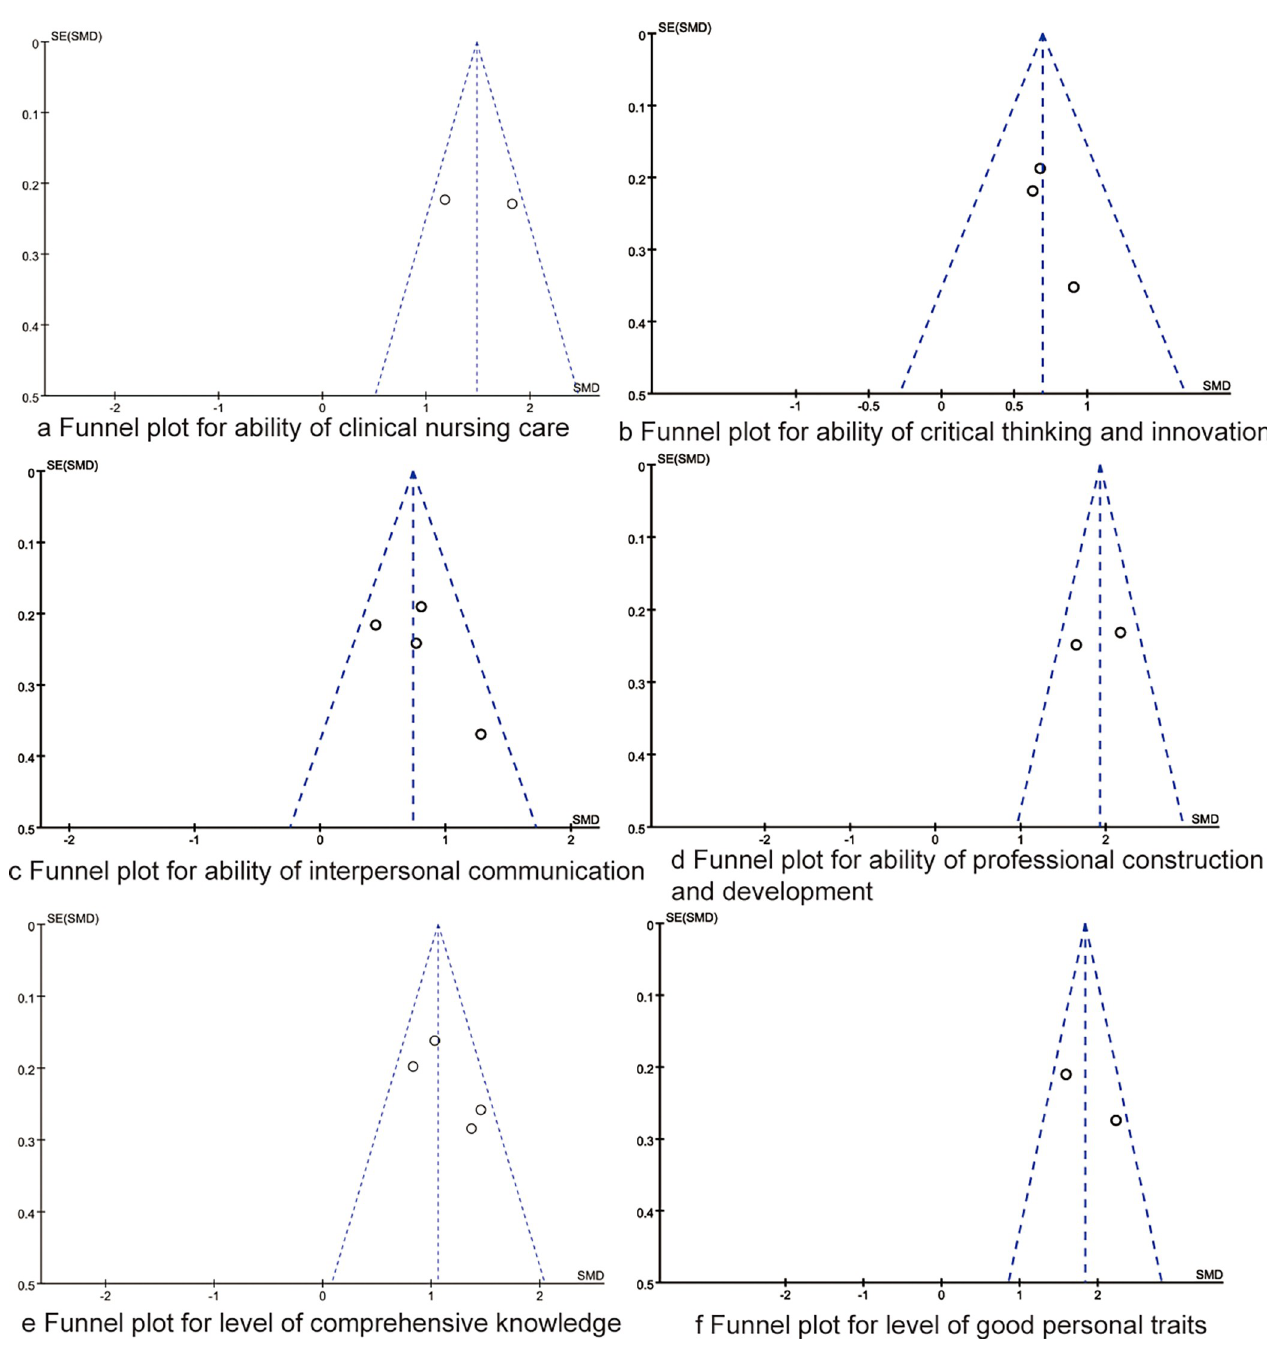
Fig 6. The funnel plots of synthesized